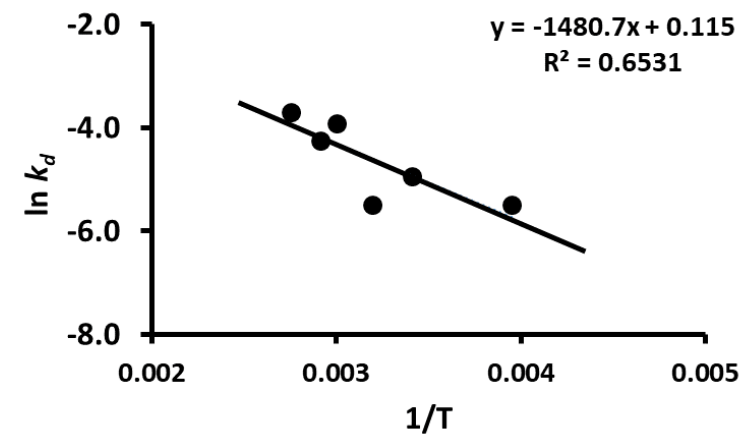
Figure 9. Plot of ln k g as a function of 1/ T .